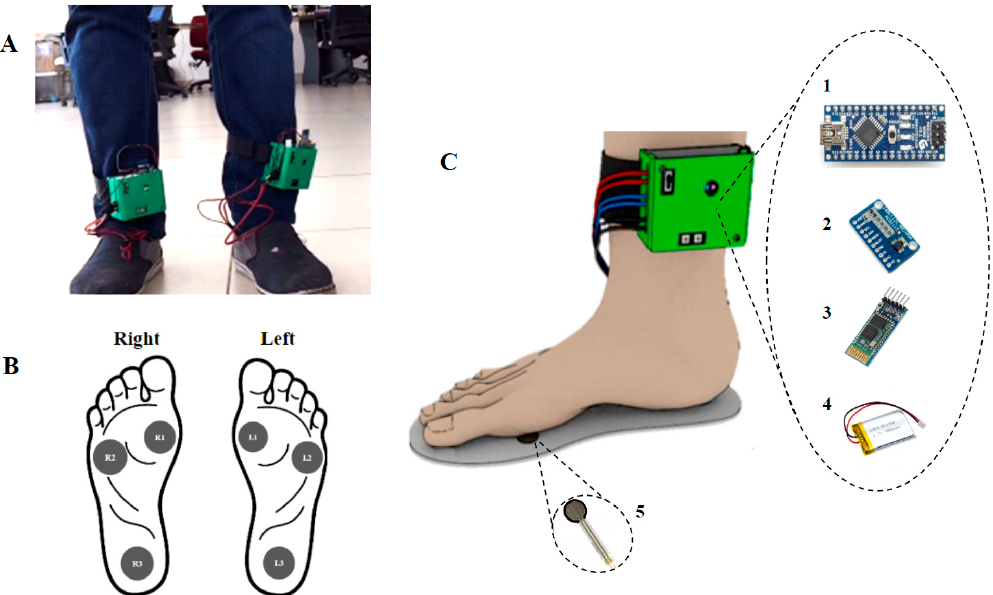
Figure 2. Plantar pressure evaluation. In ( A ), the test subject has an electronic system for the readings. In ( B ), the sensor distribution is shown on feet. In ( C ), the render represents how the system would be placed, and also shows its electronic components, such as (1) Arduino Nano: board with a microcontroller; (2) ADS1115: Board with digital analog converter channels; (3) HC-05: Bluetooth module; (4) LiPo 523450: Battery; and (5) FSR-402: Flexible pressure sensor. For the measurement of the plantar pressure, an FSR-402 was used, which is a high-